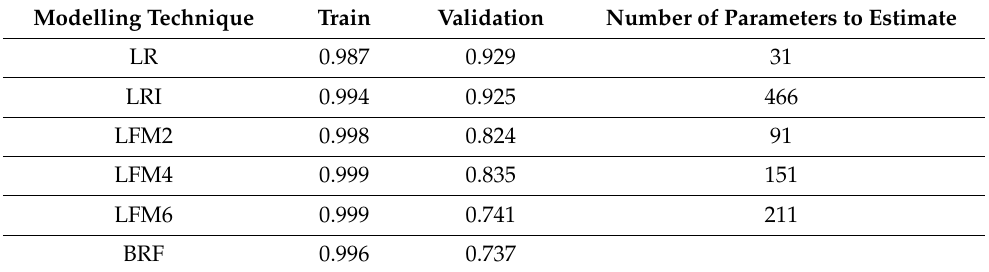
Table 12. Ginis obtained by the various models on the full data set.